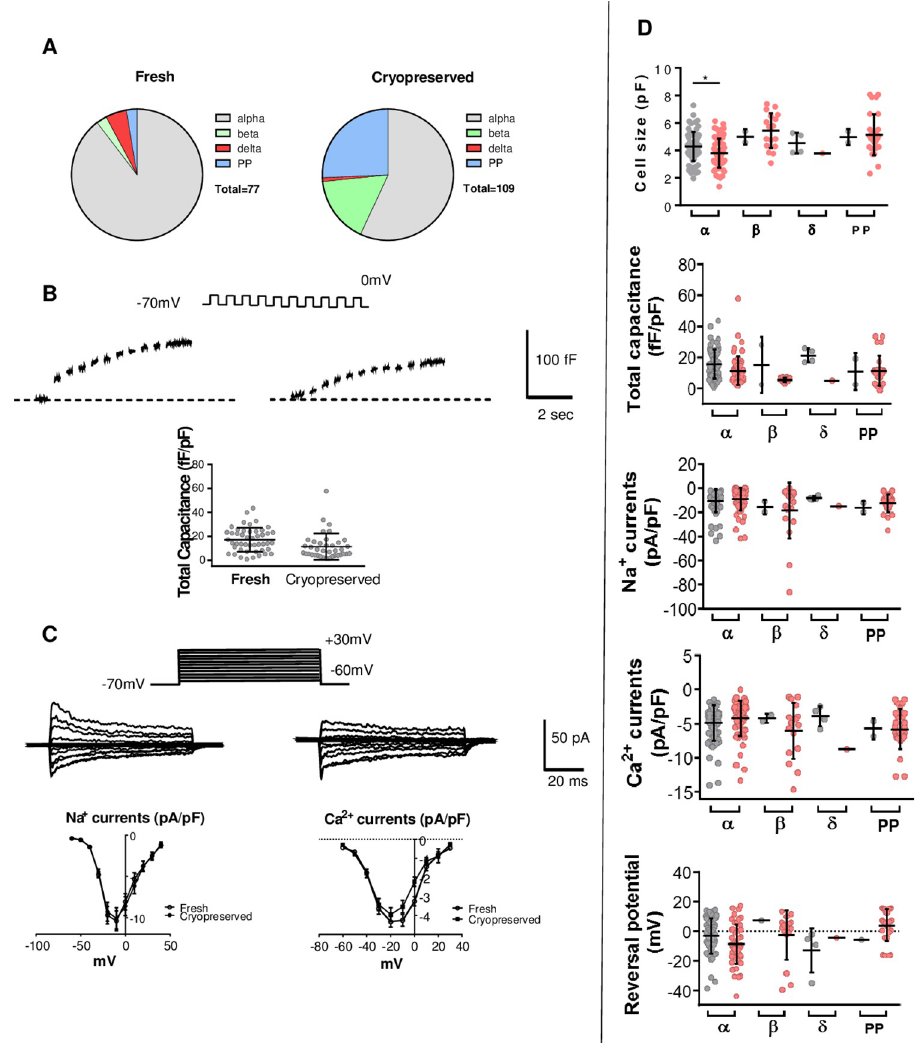
Fig 4. Representative traces from fresh and cryopreserved islet cells showing (A) total numbers of cell types patched; (B) total exocytosis in α cells; (C) top, traces of activation of voltage-gated Na + and Ca 2+ channel currents in α cells; bottom, the current-voltage relationship of voltage-gated Na + and Ca 2+ channels; (D) Summary of major electrophysiological data comparing fresh (grey) and cryopreserved (red) dispersed islet α cells, β cells, δ cells, and PP cells from three pancreatic islet donors. Data show cell size, total exocytosis, Na + and Ca 2+ currents, and reversal potential (S2 Table).